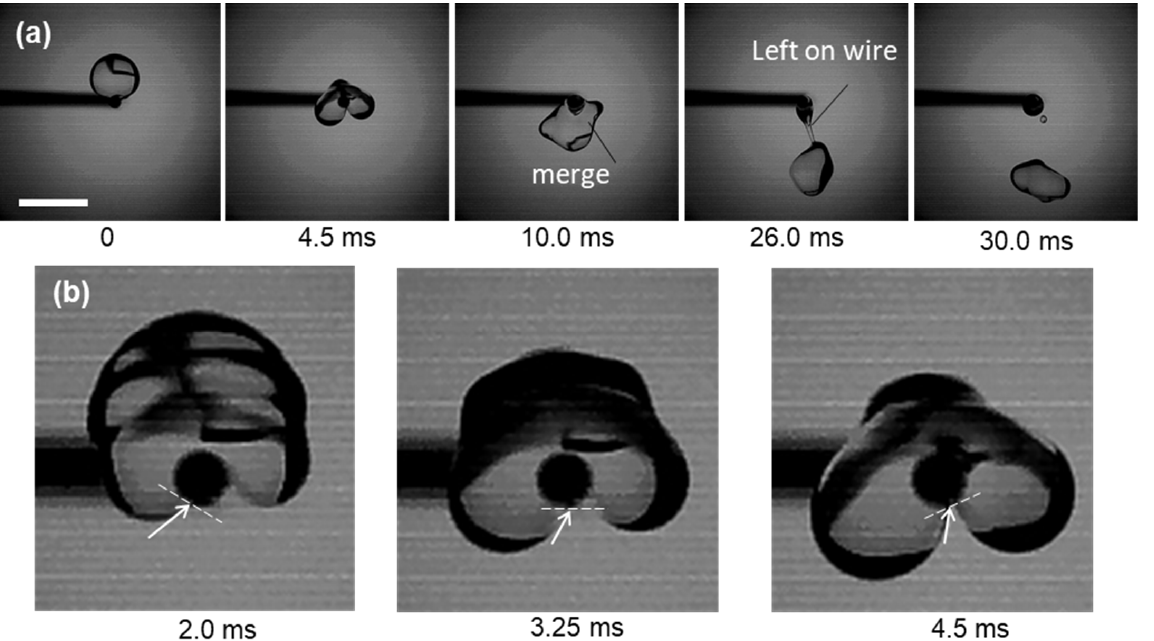
Figure 3. Impacting process of a droplet of 5.5 µ L on the hydrophilic wire. The impacting velocity of the droplet is 0.44 m/s and We = 6.2. Scale bar in ( a ) is 3 mm. The arrows and dashed lines in ( b ) indicate the tangent directions of the air–water interface and the solid surface at the contact line, respectively. When a droplet impacts the superhydrophobic wire with the same velocity and We number, the droplet splits into two halves, as shown in Figure 4a (see also Video S2 in the Supporting Information). During the impacting process, the contact angles of the advancing heads of the droplet on the superhydrophobic wire are close to the advancing contact angle of superhydrophobic coatings, i.e., 168 ◦ . Opposite to the one on the hydrophilic wire, the surface tension at the three-phase contact line hinders the advancing process of the contact line on the superhydrophobic wire with the high advancing contact angle, as marked by the arrows in Figure 4b. It avoids the two advancing heads from merging during the impacting process. Instead, the inertia of the two advancing heads makes them keep moving downward to split the droplet into two halves with no noticeable satellite droplets left on the